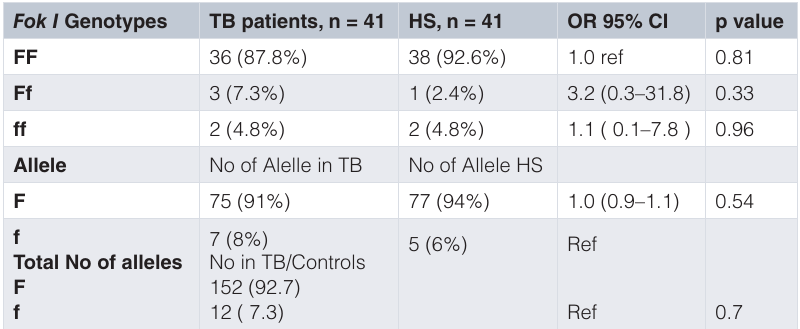
Table 2. Genotype and allele distribution of fok I gene among TB patients and controls.